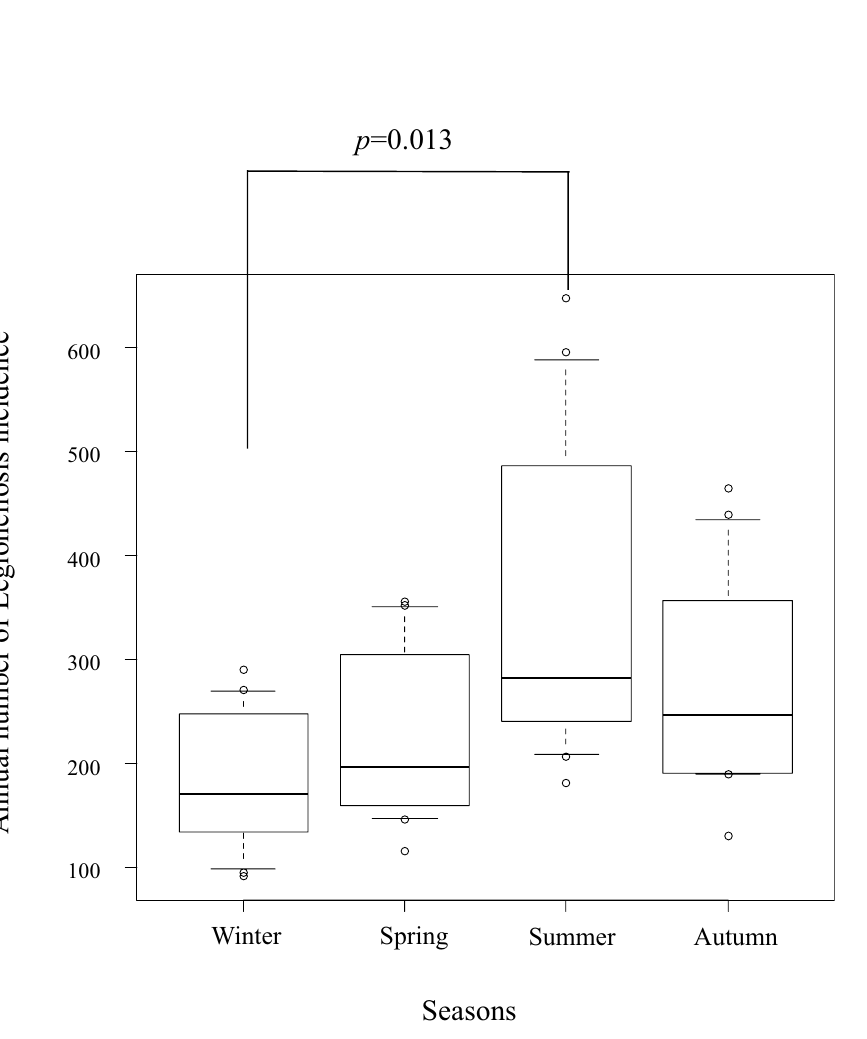
Figure 3. Comparison of the incidence of legionellosis among the 4 seasons, 2006–2017. Shown are the box and whisker plots with median and 10th to 90th percentiles. Mann–Whitney U test revealed a significant difference (p = 0.013) between winter and